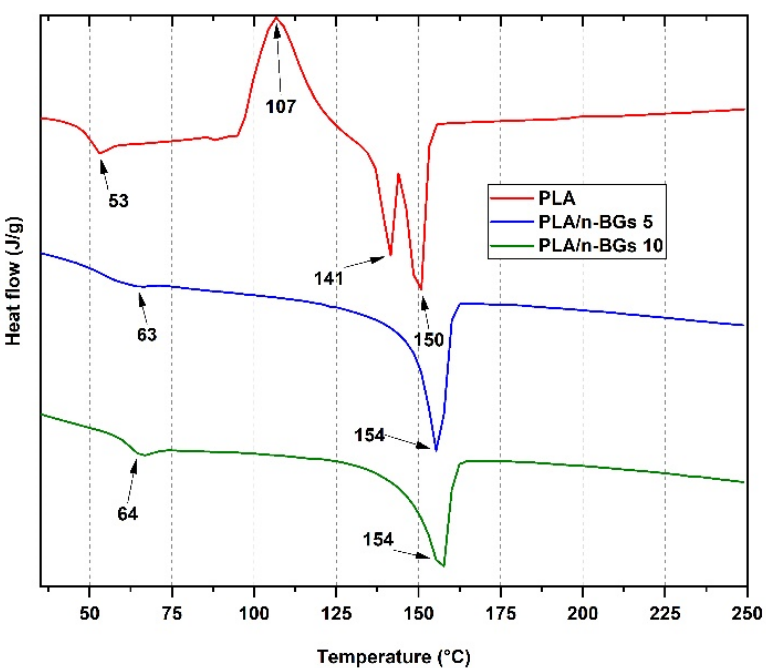
Figure 7. DSC thermograms for the neat PLA nanocomposites, PLA/n-BGs 5 wt.%, and PLA/n-BGs 10 10 wt.%.